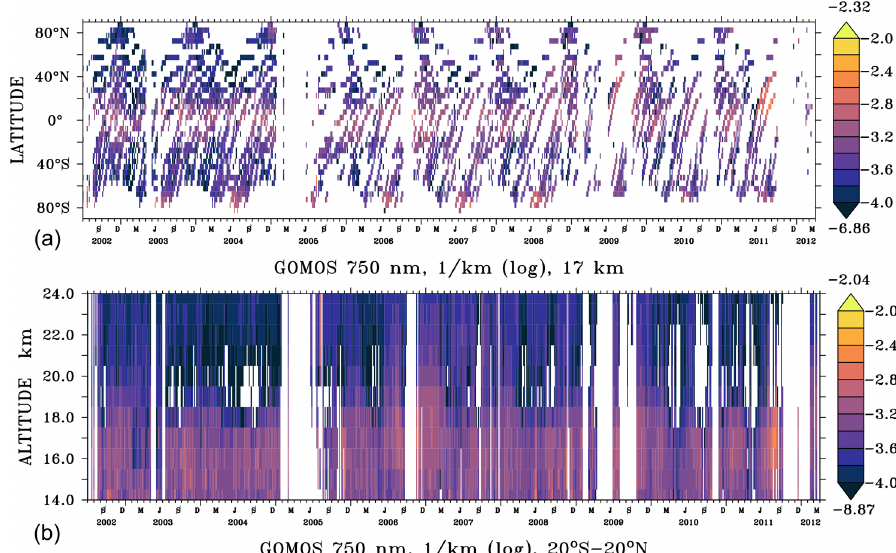
Figure 3. Like Fig. 2 but for the 750nm